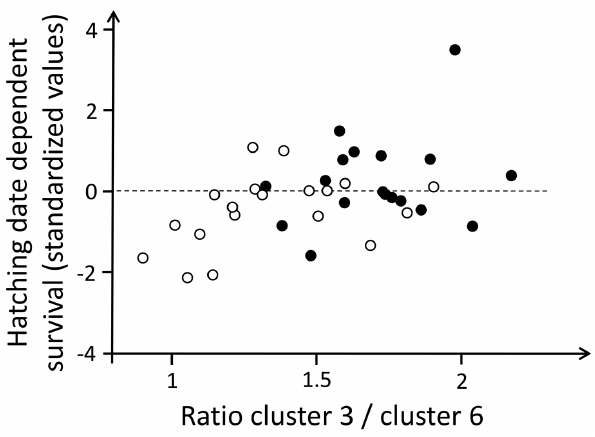
Figure 2. Hatching date dependent nymph survival in relation to the ratio of cluster 3/cluster 6 CHC. The hatching date dependent survival rate was computed as the product of the standardized residuals (with respect to treatment means) of the proportion of nymphs alive and of hatching date. Positive values imply lower than average survival in early hatching broods or higher than average survival in late hatching broods. Negative values imply higher than average survival in early hatching broods or lower than average survival in late hatching broods. The CHC clusters 3 and 6 were selected based on variable clustering and a step-wise linear regression (see